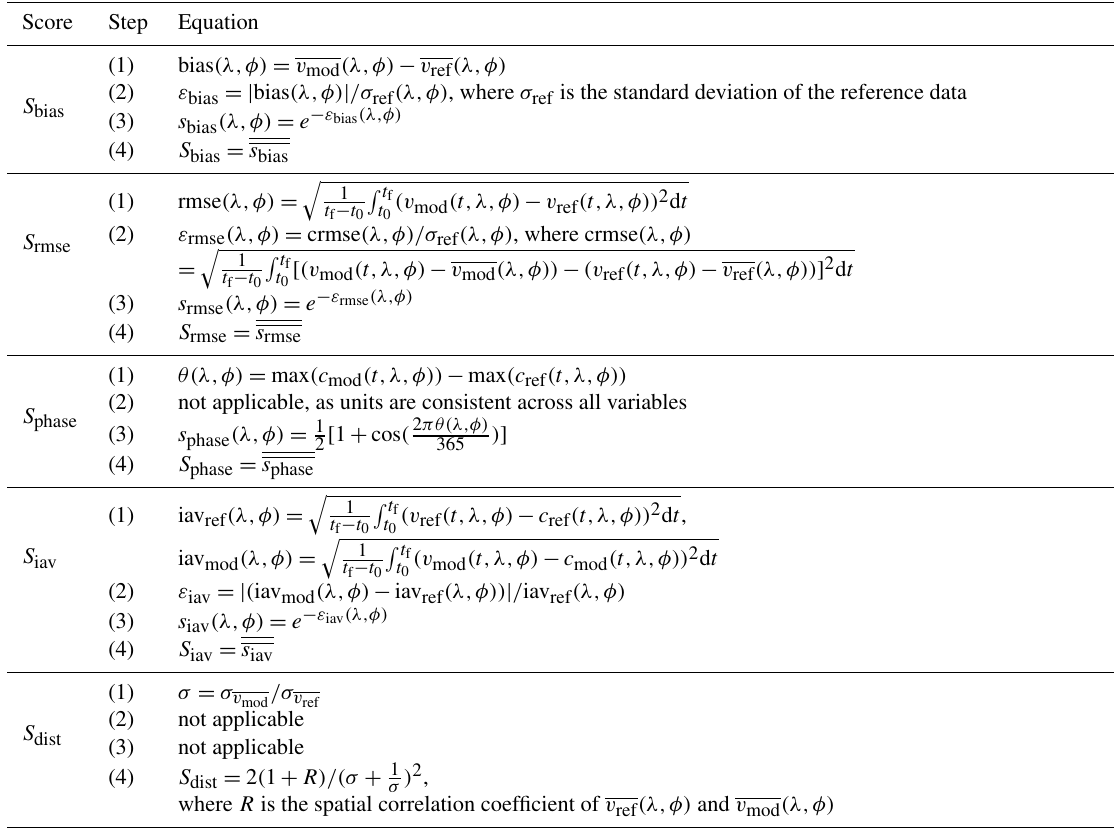
Table A1. Equations used for computing spatially integrated scalar scores for each variable. The four steps refer to (1) the definition of the statistical metric, (2) non-dimensionalization, (3) conversion to unit interval, and (4) spatial integration. The integration limits t 0 and t f are the initial and final time step, respectively. The variables c mod and c ref refer to the monthly mean annual cycle of the model and reference data, respectively. “iav” is the interannual variability. “crmse” is the “centralized RMSE”, which is the RMSE of the anomalies. This ensures that the RMSE score excludes also considering the bias, which is captured by the bias